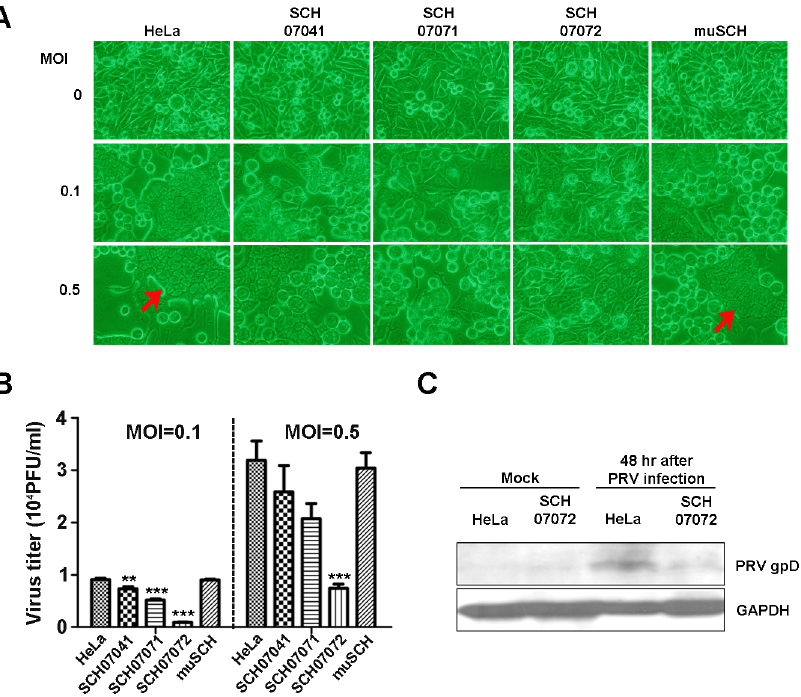
Figure 3. 3D8 scFv expression in transgenic HeLa cells confers resistance to PRV. A . Three 3D8 scFv cell lines and one mutant 3D8 scFv cell line were challenged with PRV at two different MOIs (0.1 and 0.5). The multinuclear giant cell formation was less frequent in the SCH07072 lines than that in the other cell lines including wild type cells. Red arrow points to CPE (multinuclear giant cell formation). B . Wild-type HeLa, SCH07072, and muSCH cells were infected with PRV at 0.1 and 0.5 MOI. Plaque assay data showed the highest antiviral effects in SCH07072 cells (0.1 MOI: HeLa=9,130.00 6 222.79, SCH07041=7,340.00 6 389.74, SCH07071=5,190.00 6 182.30, SCH07072=916.67 6 52.07, muSCH=9,046.67 6 145.18; 0.5 MOI: HeLa = 31,833.33 6 3,755.14, SCH07041 = 25,866.67 6 4,969.35, SCH07071 = 20,700.00 6 2,902.30, SCH07072 = 7,466.67 6 762.31, muSCH=30,400.00 6 2,959.73). Data bars show mean 6 standard error. **, *** indicate significant differences from HeLa cells at p , 0.01 and p , 0.001 , respectively (one-way analysis of variance and Tukey’s post hoc t -test). C . Western blot analysis using an anti-PRV gpD antibody